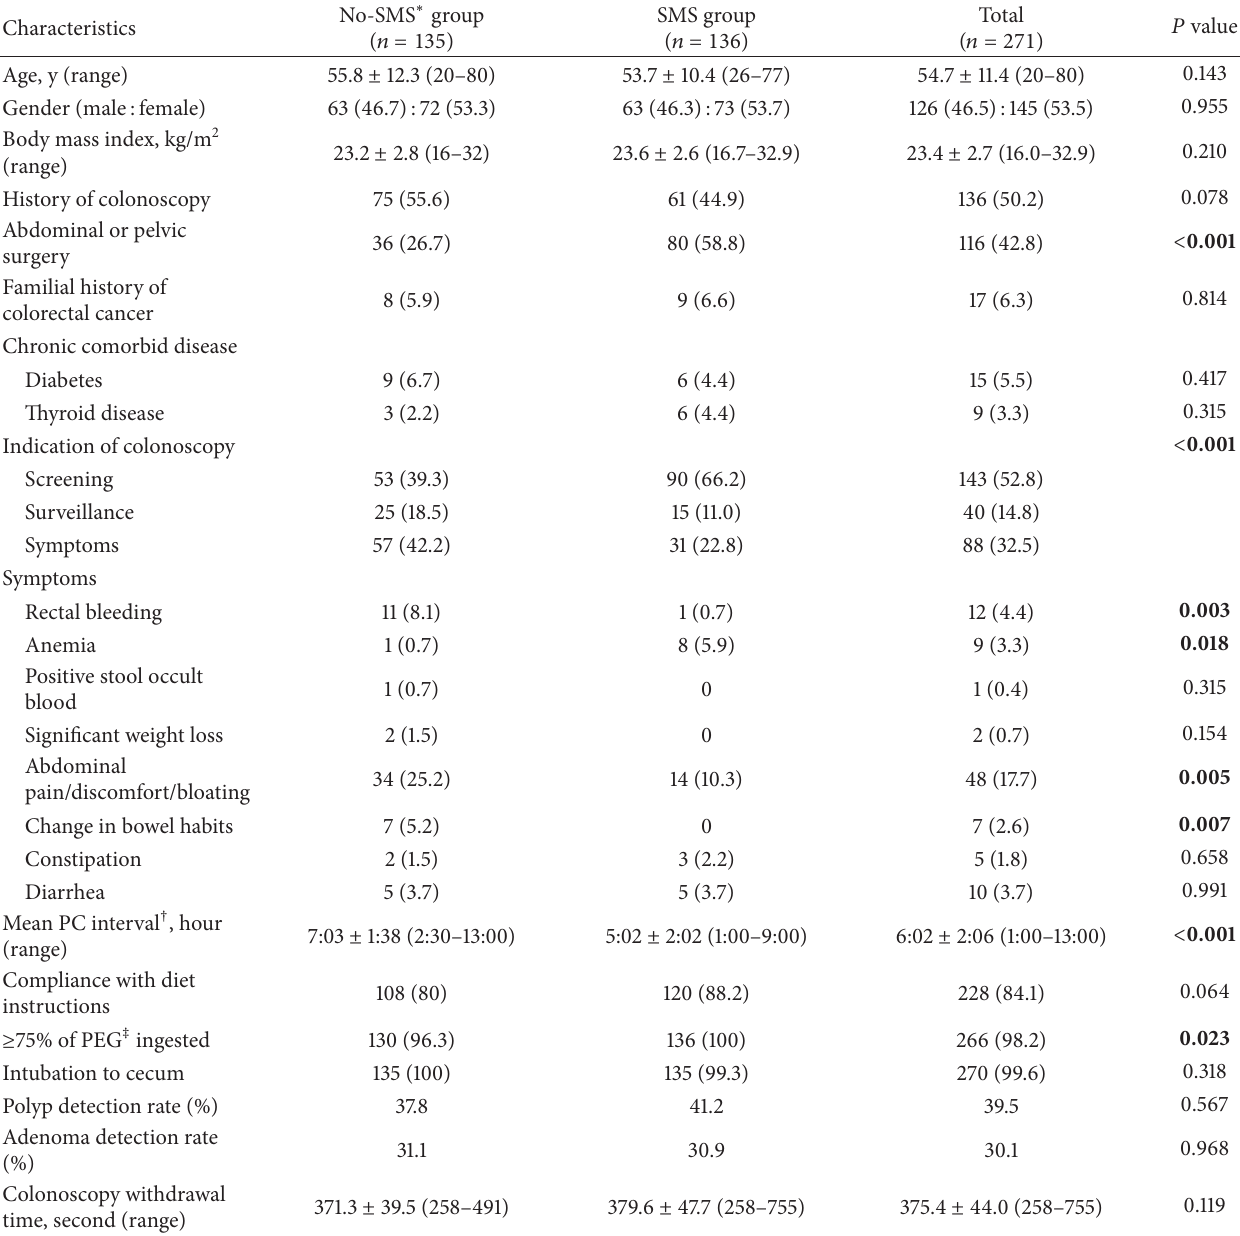
Table 2: Basal characteristics of the study